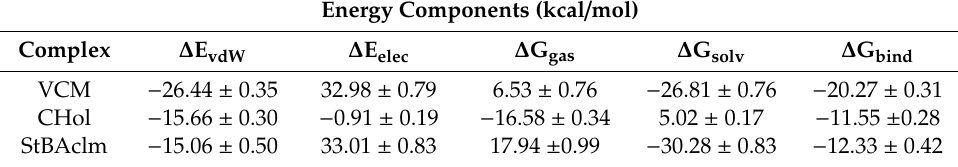
Table2. Thebindingenergies(kcal / mol)fortheVCM-CHol-StBAclmcomputedfromtheMDtrajectories. Table 2. The binding energies (kcal/mol) for the VCM-CHol-StBAclm computed from the MD A ffi nity energy values and energy components. Van der Waals contributions ( ∆ EvdW); electrostatic trajectories. Affinity energy values and energy components. Van der Waals contributions ( Δ EvdW); contributions ( ∆ Eele); Change in free energy in gas ( ∆ Ggas) and solvent phase ( ∆ Gsolv) of the process electrostatic contributions ( Δ Eele); Change in free energy in gas ( Δ Ggas) and solvent phase ( Δ Gsolv) of protonation; Binding free energy ( ∆ G bind). of the process of protonation; Binding free energy ( Δ G bind).